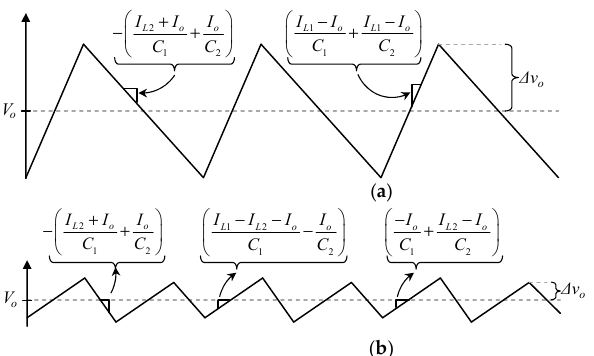
Figure 7. Zoom into the output voltage ripple ( a ) in the former strategy and ( b ) in the proposed strategy.